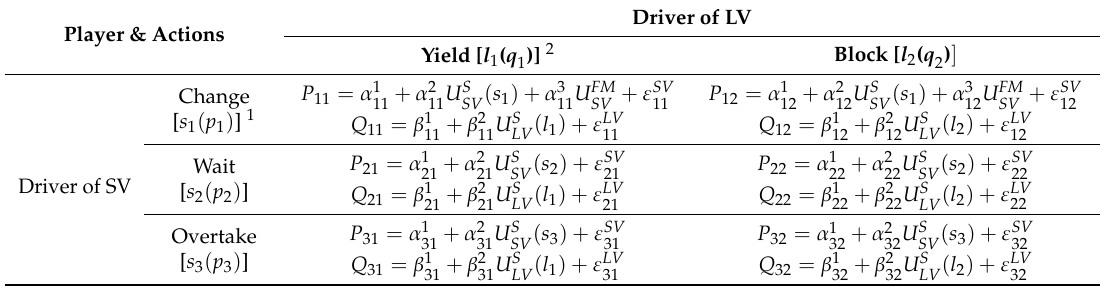
Table 1. Game Structure and Payoff Functions of the Merging Decision-Making Game in Normal Form.